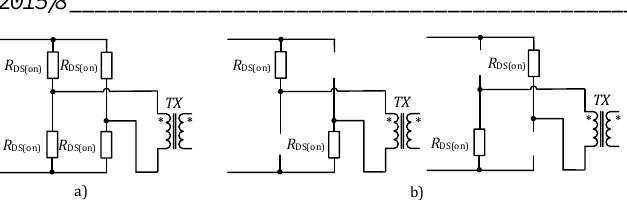
Fig. 5. Equivalent scheme of the inverter during the shoot-through (a) and the active (b) state. MOSFETs conduction losses that corresponds to the shoot- through state is only two times higher than in IFBB